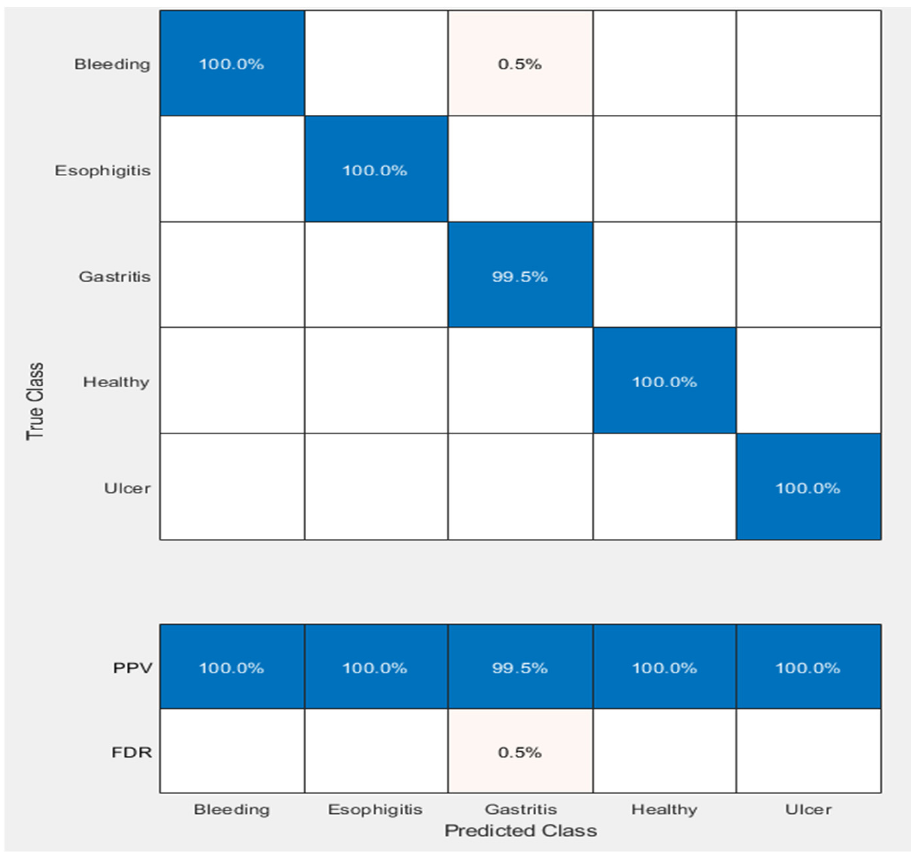
Figure 7. Confusion matrix (false discovery rates) of cubic SVM using fused features.